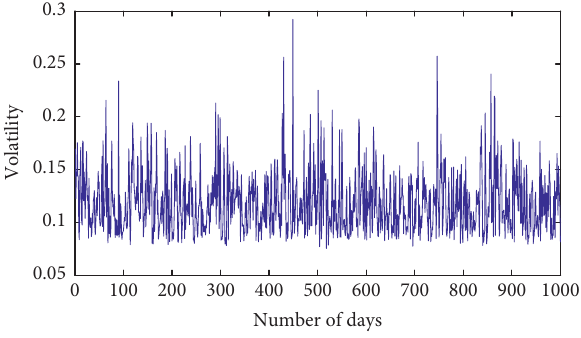
Figure 10: The estimated volatility for T � 1000.